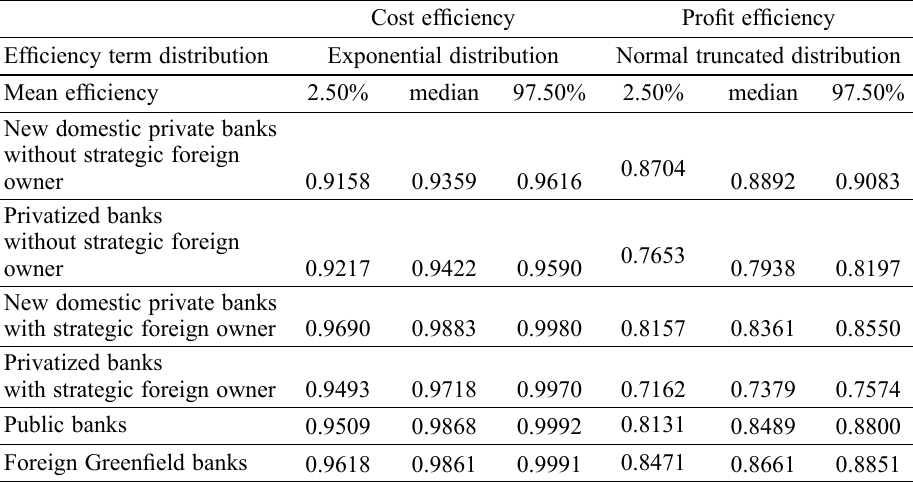
Table 9. Estimated mean bank efficiency according to its type of ownership and distinguishing the presence/absence of a strategic foreign owner in the bank